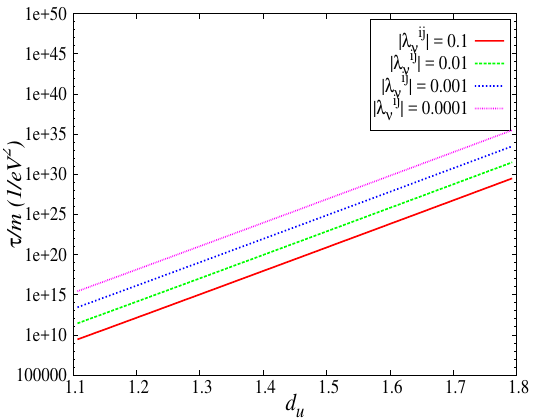
Figure 1 . The variations of the neutrino decay lifetime ( (cid:28)=m ) with the unparticle dimension ( d U ) are shown for four di(cid:11)erent values (0.1, 0.01, 0.001, 0.0001) of couplings j (cid:21) ij